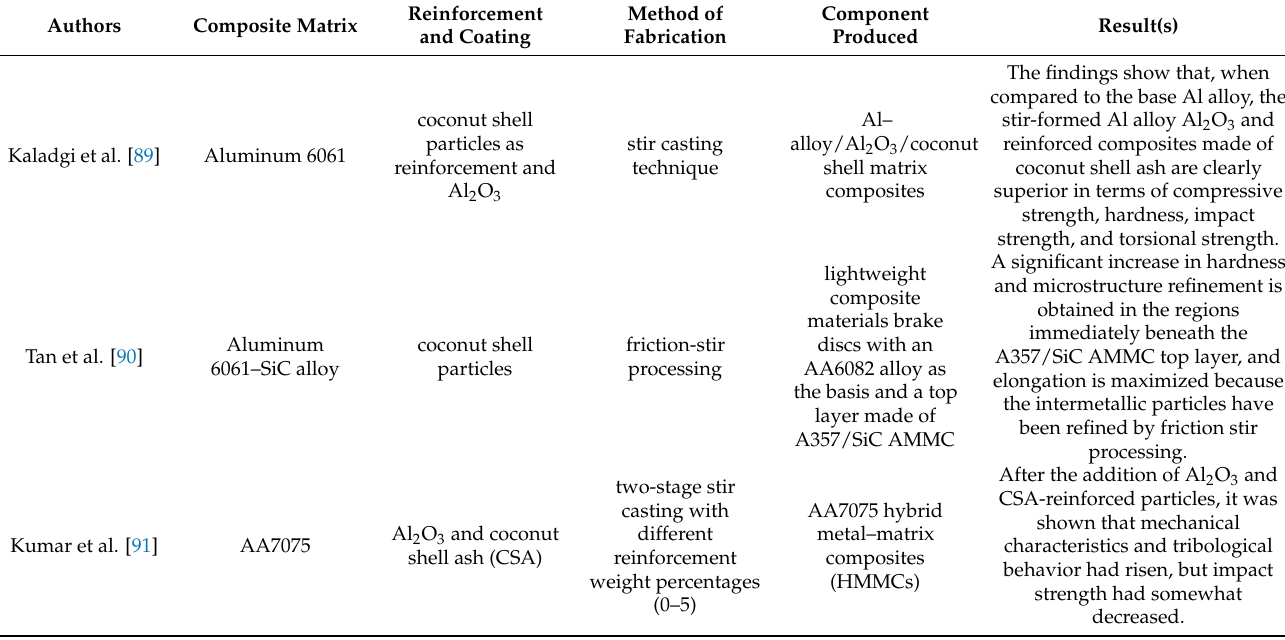
Figure 10. Process employed to produce AMMCs [87,88]. Table 1. Summary of a different method of fabrication of reinforcement, its composites